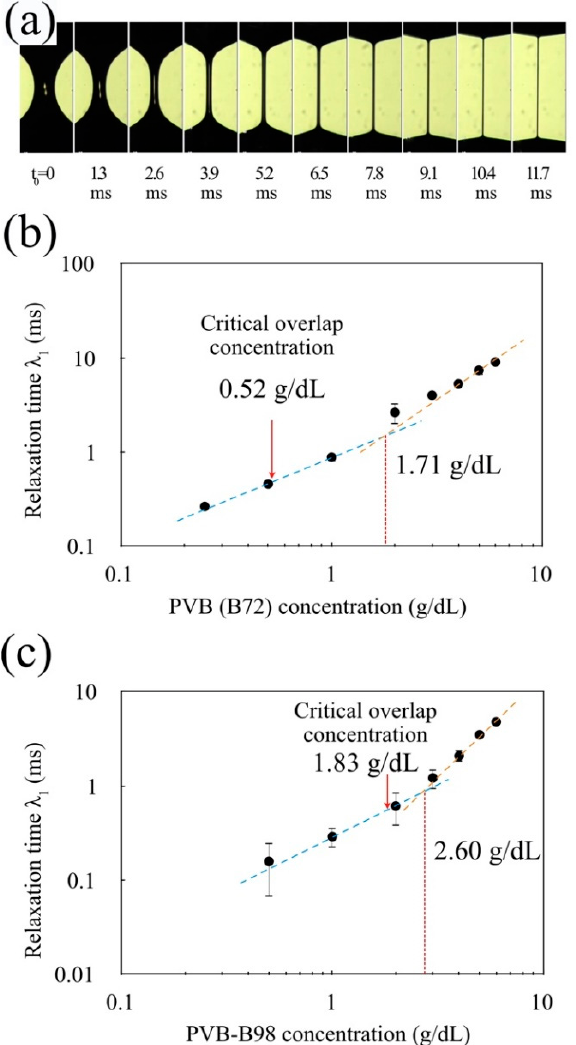
Figure 5. ( a ) Filament break-up experiment with PVB-B72 (2 g/dL) in a benzyl alcohol solution. ( b ) Concentration dependence of the relaxation time for high-molecular-weight PVB-B72. ( c ) Concen- tration dependence of the relaxation time for low-molecular-weight PVB-B98.